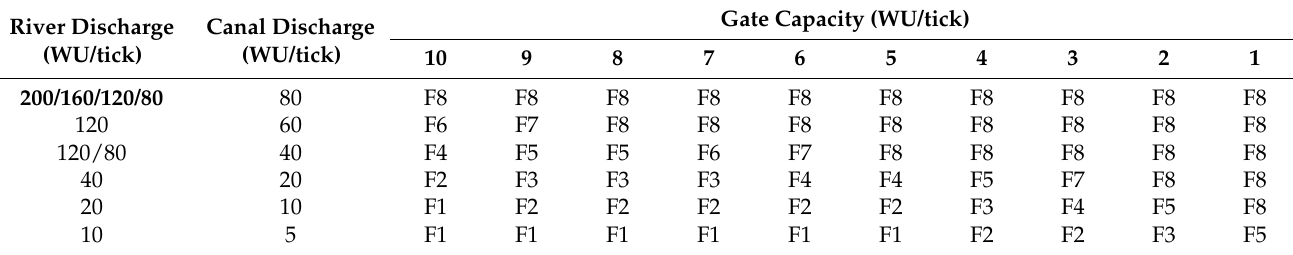
Table 2. The furthest farmer that the water flow